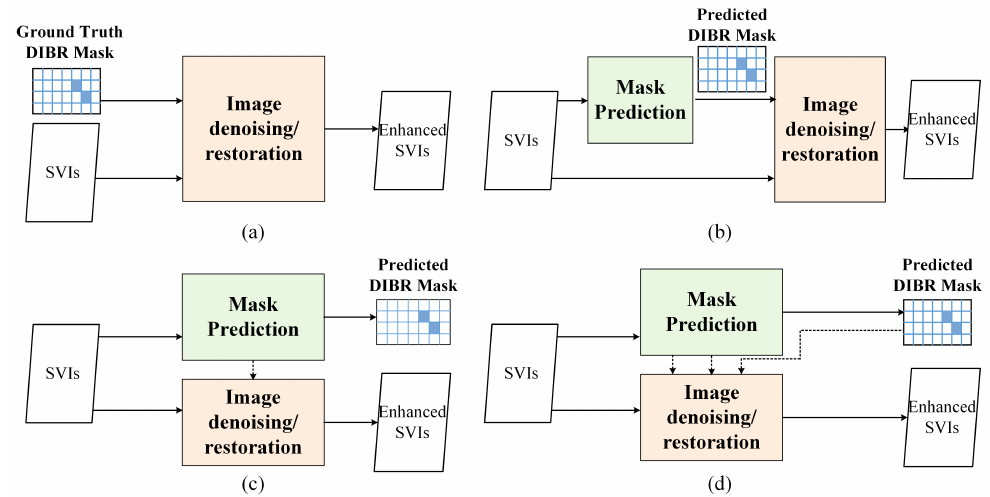
Figure 5. Four possible ways of image denoising/restoration networks integrating with DIBR distor- tion position. ( a ) Intuitive way of integrating ground truth DIBR distortion position. ( b ) Successive networks with DIBR distortion prediction. ( c ) Parallel networks with DIBR distortion prediction. ( d ) Parallel interactive network with DIBR distortion